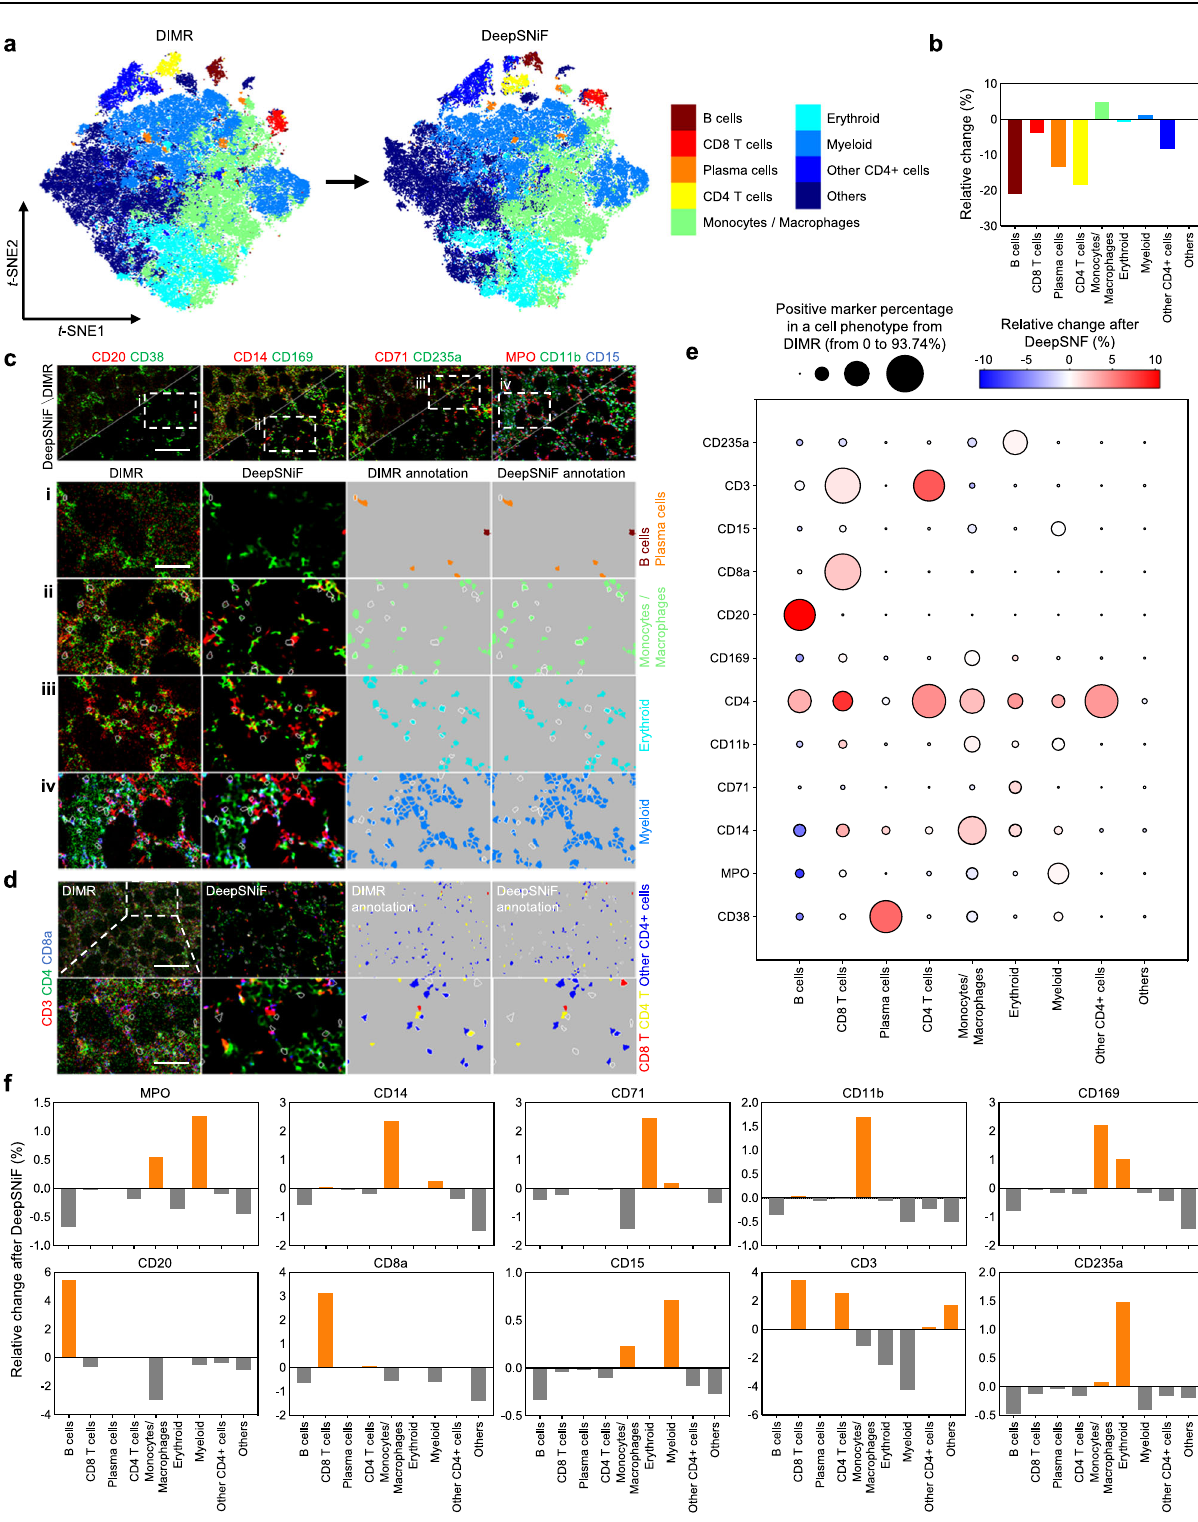
marker signals reduce while the speci fi c ones enrich in the cell types, respectively. The circle size indicates the positive marker percentage in a particular phenotype of DIMR, and the circle color indicates the relative changes of the positive rate for the particular markers after DeepSNiF enhancement. f DeepSNiF enhances the speci fi city of cell phenotyping. With DeepSNiF denoising, the ratios of speci fi c phenotypes increase while those of non-speci fi c phenotypes decrease in the posi- tive markers. The relative change is the difference in percentage composition of each celltype beforeand afterDeepSNiFenhancement.Scale bar: c 110 μ m. d Top: 145 μ m, bottom: 50 μ